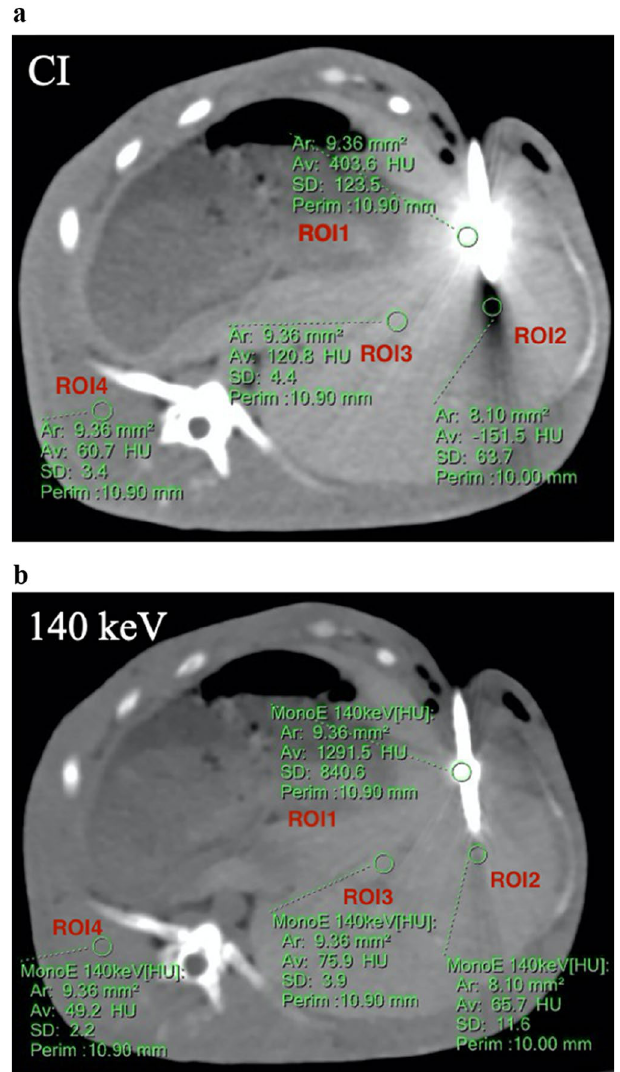
Figure 1. ( a ) Place the regions of interest on conventional images (CIs) in the hyperdense artifacts (ROI 1 ), hypodense artifacts (ROI 2 ), surrounding liver parenchyma with the presence of artifacts (ROI 3 ) and distant regions of back muscles that were not affected by artifacts (ROI 4 ). ( b ) The single virtual monoenergetic image with different levels was then “copy-paste” to ensure that the position, shape and size of the ROIs were exactly the